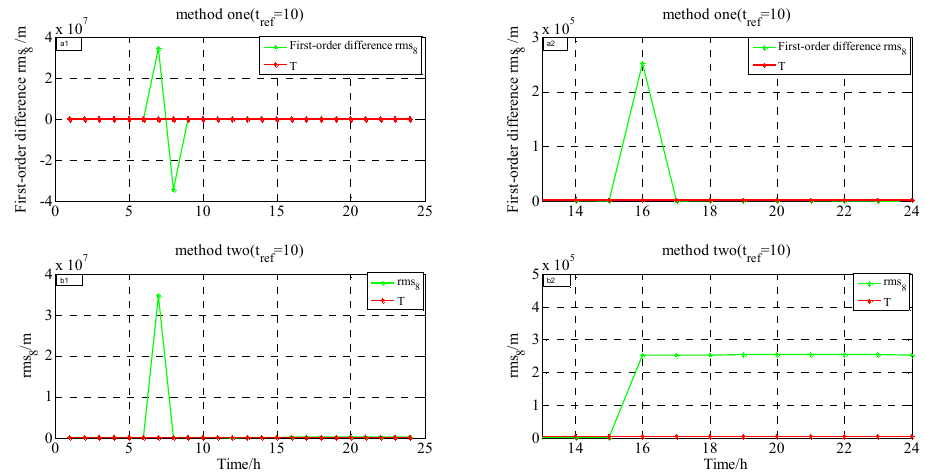
Figure 10. ( a1 ) The results for method one ( ∇ rms 8 ( t ) ), ( a2 ) The results for partial enlarged ( a1), and ( b1 ) The results for method two ( rms 8 ( t ) ), ( b2 ) The results for partial enlarged ( b1 ).